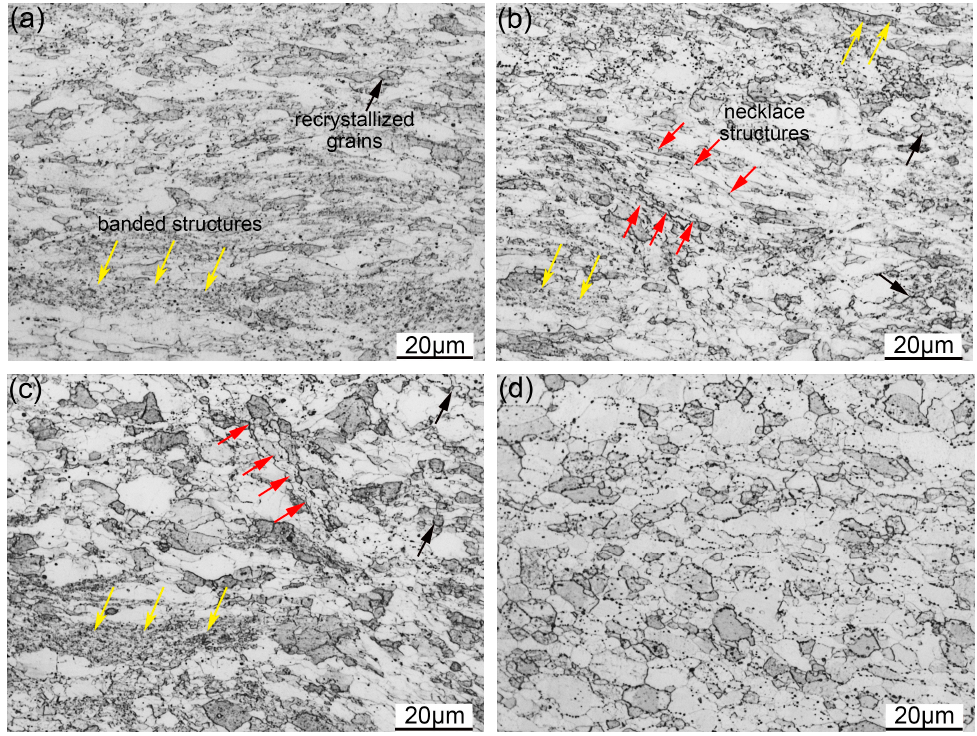
Figure 7. OM images of the samples deformed with the strain rate of 0.01 s − 1 at ( a ) 1050 ° C; ( b ) 1100 ° C; ( c ) 1150 ° C; ( d ) 1200 ° C. Materials 2018 , 11 , x FOR PEER REVIEW